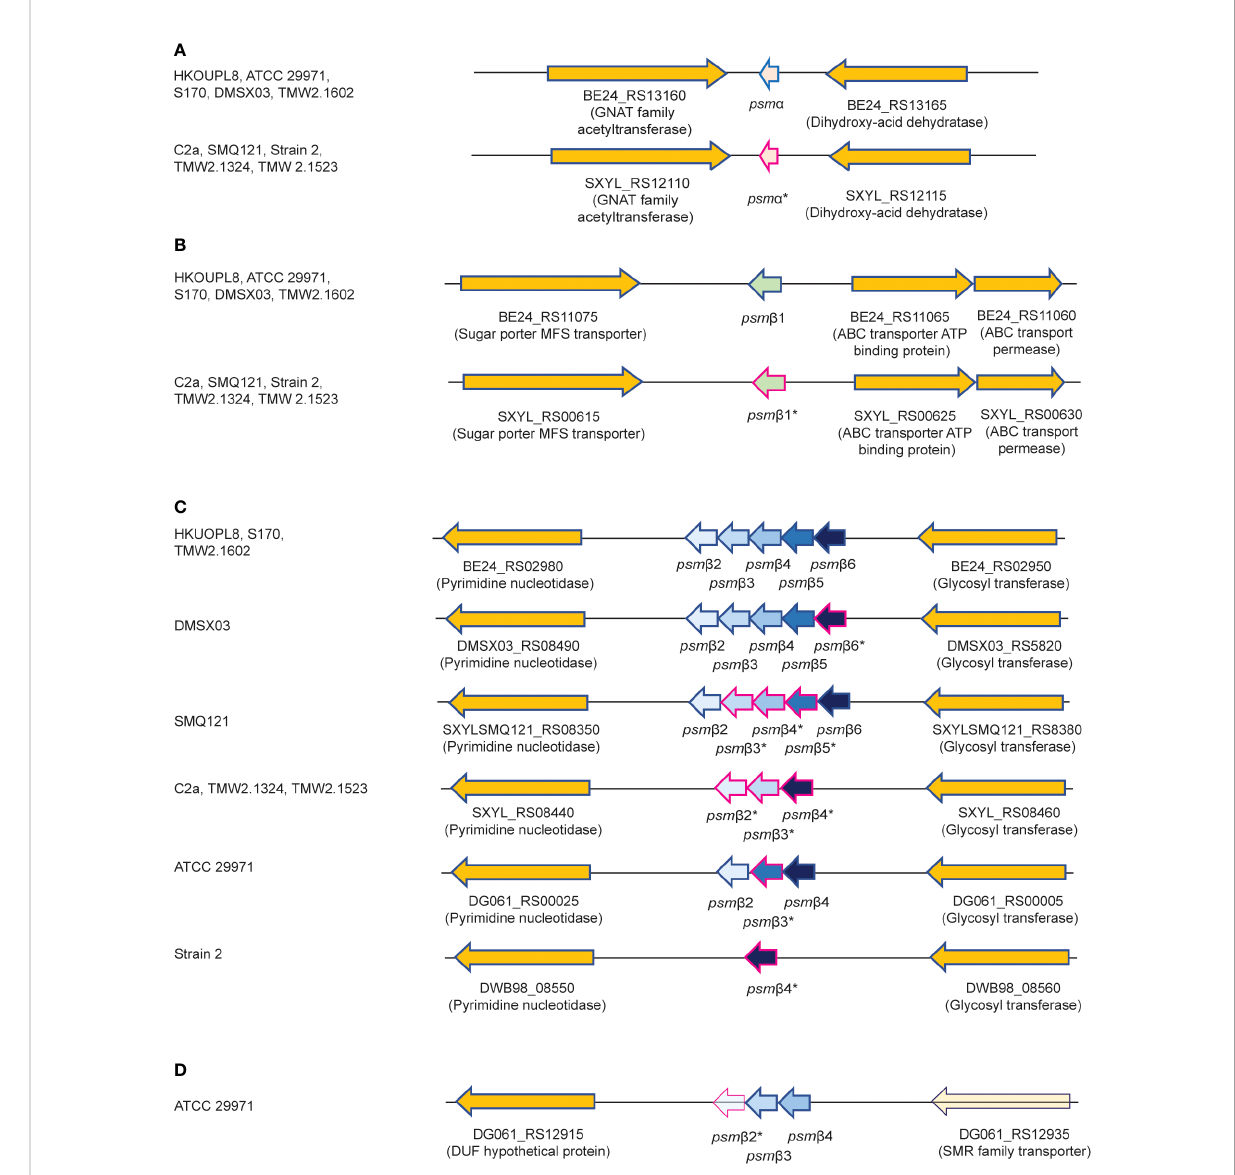
FIGURE 2 Amino acid sequences of S. xylosus PSMs and encoding genetic loci. (A) Genetic location of the psm a gene. (B) Genetic location of the psm b 1 gene. (C) Genetic location of the psm b 2-6 operon. Strain HKUOPL8 is used for reference (underlined) for the location of psm a , psm b 1 and psm b 2-6. (D) Genetic location of a second psm b operon in ATCC 29971. *Genes encoding PSM variants are denoted by a fuchsia border around the arrow depicting the gene. For some PSM b -type peptides, multiple variants exist but are not distinguished here. A complete list of predicted amino acid sequences of S. xylosus psm genes and variants can be found in Table